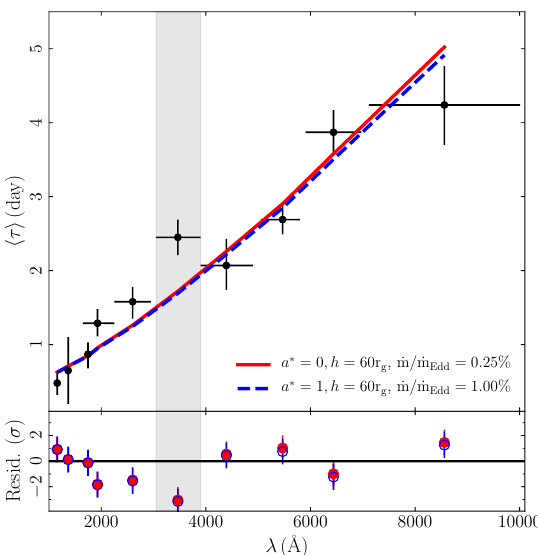
Figure 2. Best-fit models for a ∗ = 0 (solid line) and a ∗ = 1 (dashed line) obtained by fitting the observed time lags, excluding the measurement in the U